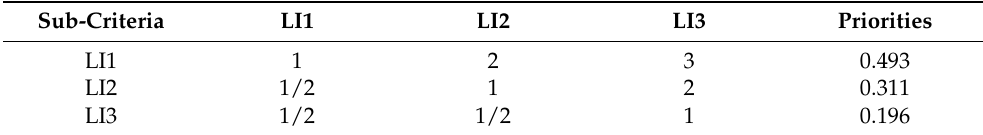
Table 8. Pairwise comparison matrix for the sub-criteria with respect to LI. Sub-Criteria LI1 LI2 LI3 Priorities LI1 LI3